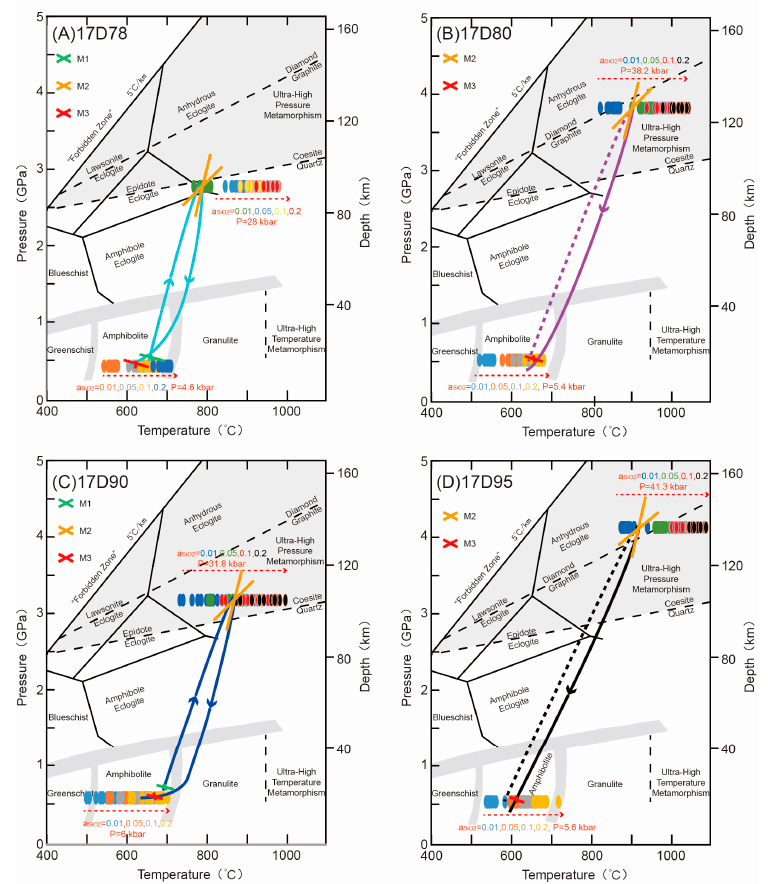
Figure 7. Metamorphic P-T paths of the four garnet clinopyroxenite samples. ( A ) Sample 17D78. ( B ) Sample 17D80. ( C ) Sample 17D90. ( D ) Sample 17D95. In each figure, M1, M2, and M3 represent the prograde, peak, and retrograde metamorphism, respectively. The red dotted arrows, and their neighboring annotations and different colored ellipses represent the temperature results obtained by Zr-in-titanite geothermometer [40] with variable activities of SiO2 (0.01, 0.05, 0.1, and 0.2). P = 28 kbar means that the pressure for Zr-in-titanite calculation was set as 28 kbar. The grey thick and black thin boundaries of metamorphic facies are taken from O’Brien and Rötzler [52] and Winter [53], respectively. The diamond = graphite and quartz = coesite polymorph transition curves are taken from Kennedy and Kennedy [54] and Bose and Ganguly [55], respectively.